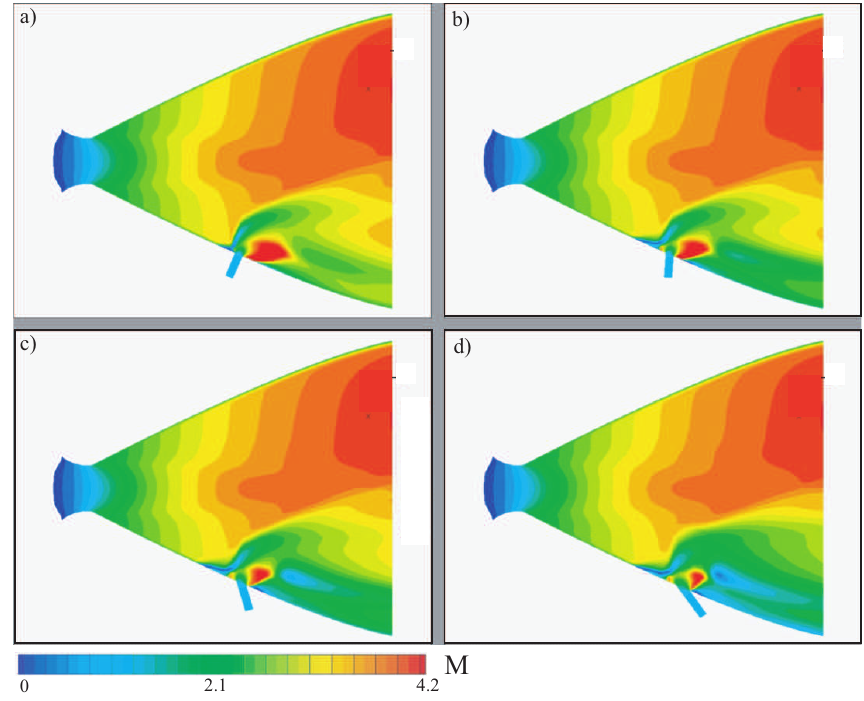
Figure 13. Contours of the Mach number for α j = 90 ◦ ( a ), 100 ◦ ( b ), 130 ◦ ( c ) and 150 ◦ ( d ). The pressure contours for various pressure ratios are shown in Figure 14. As a result of the injection, there is a sharp increase in pressure in the separation region located in front of the injection nozzle,and a decrease in pressure in the separation region located behind the injection nozzle. Depending on the pressure ratio of the injected jet, the pressure distribution in the anterior separation region has one maximum or two maxima.